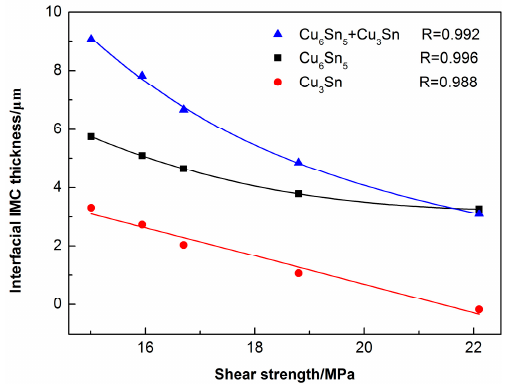
Figure 12. Relationship between shear strength and interfacial Cu 6 Sn 5 and Cu 3 Sn thickness.